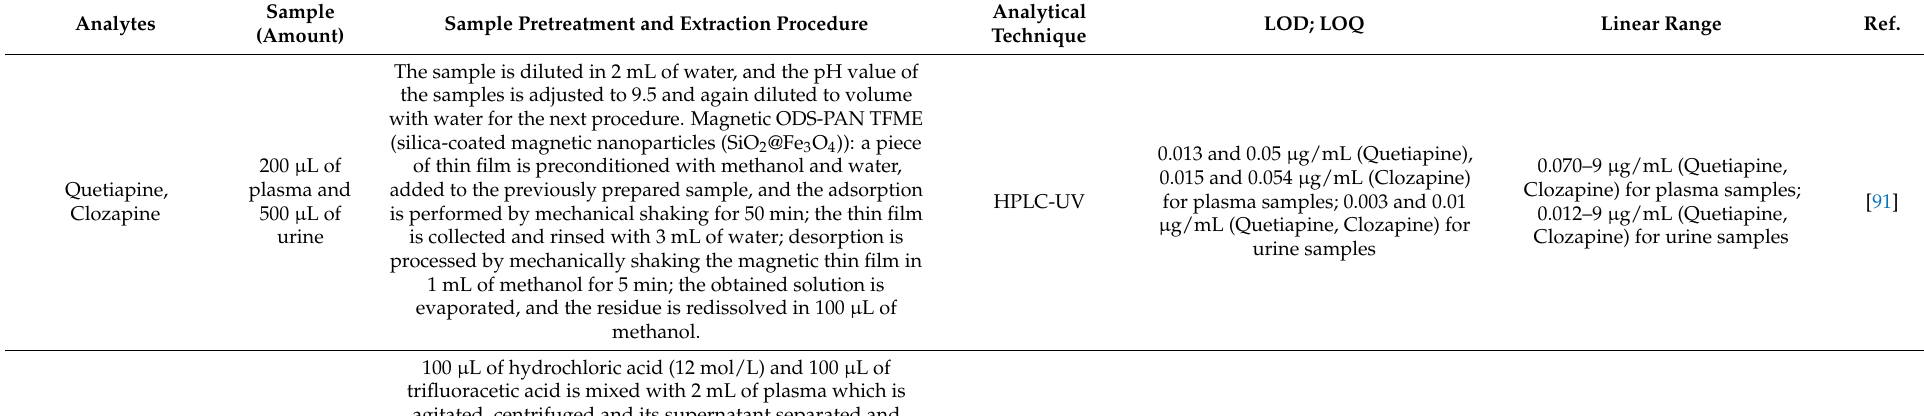
Table 10. Bioanalytical procedures using MIP and TFME approaches for